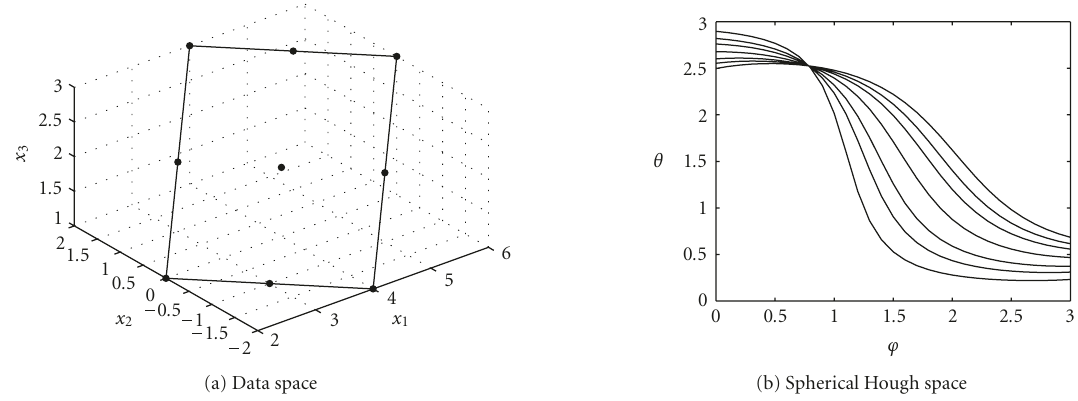
Figure 3: Illustration of the “hyperplane detecting” Hough transform in three dimensions: a point ( x 1 , x 2 , x 3 ) in the data space (a) is mapped onto the curve { ( ϕ , θ ) | θ = arctan( x 1 cos ϕ + x 2 sin ϕ ) + π/ 2 } in the parameter space [0, π ) 2 (b). The Hough curves of points belonging to one plane in data space intersect in precisely one point ( ϕ , θ ) in the Hough space and the points lie on the plane given by the normal vector (cos ϕ sin θ ,sin ϕ sin θ ,cos θ ).